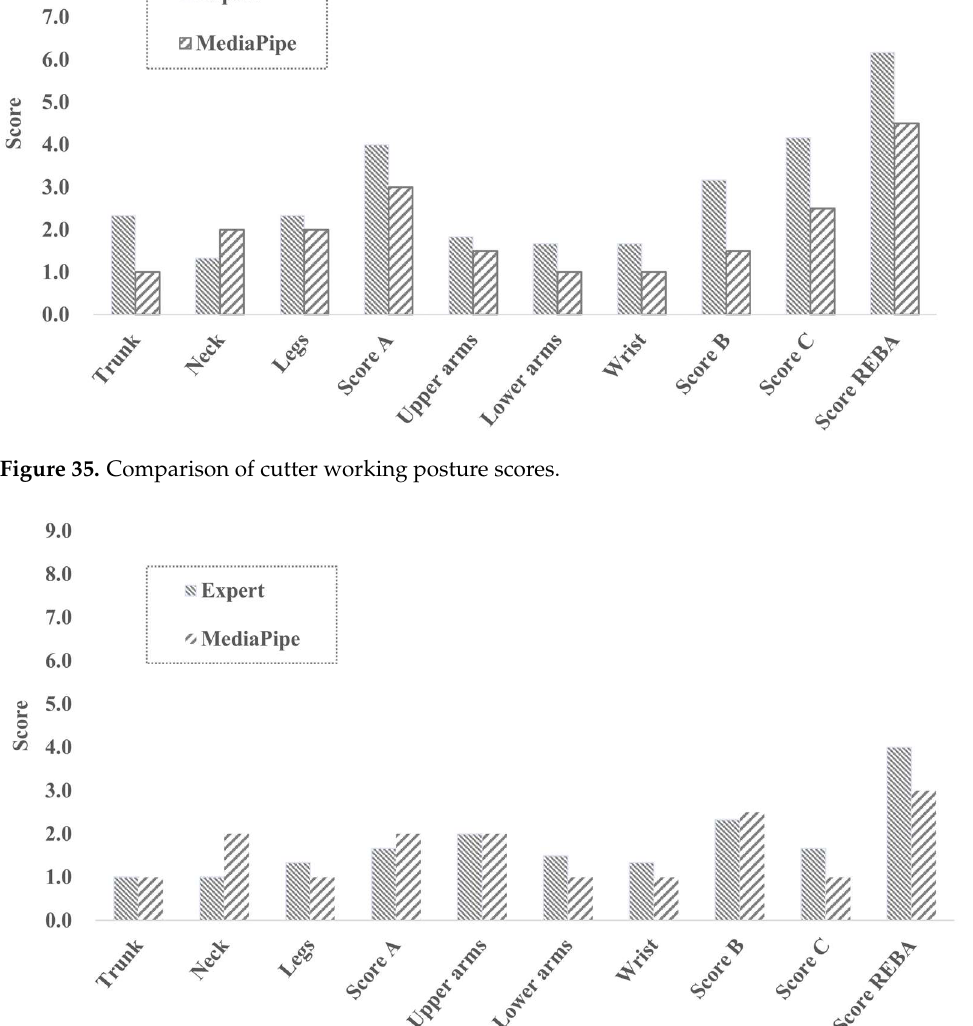
Figure 37. Comparison of drilling machine working posture scores. As a result of the comparison of the saw working posture scores (Figure 38), scores for each joint were similar overall, with a maximum error of one point, and MediaPipe scores were higher in all parts except for the trunk. The REBA scores were six points and five points, indicating the same action level (Level 2).